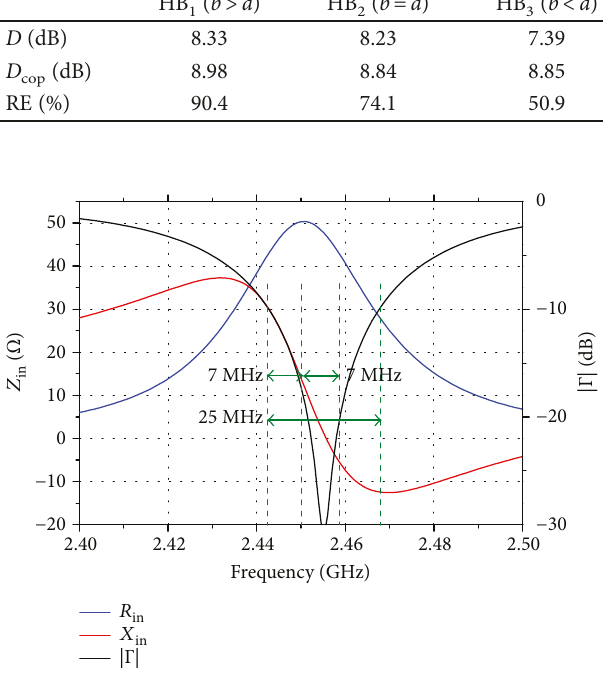
Figure 10: HB input impedance and re fl ection coe ffi cient